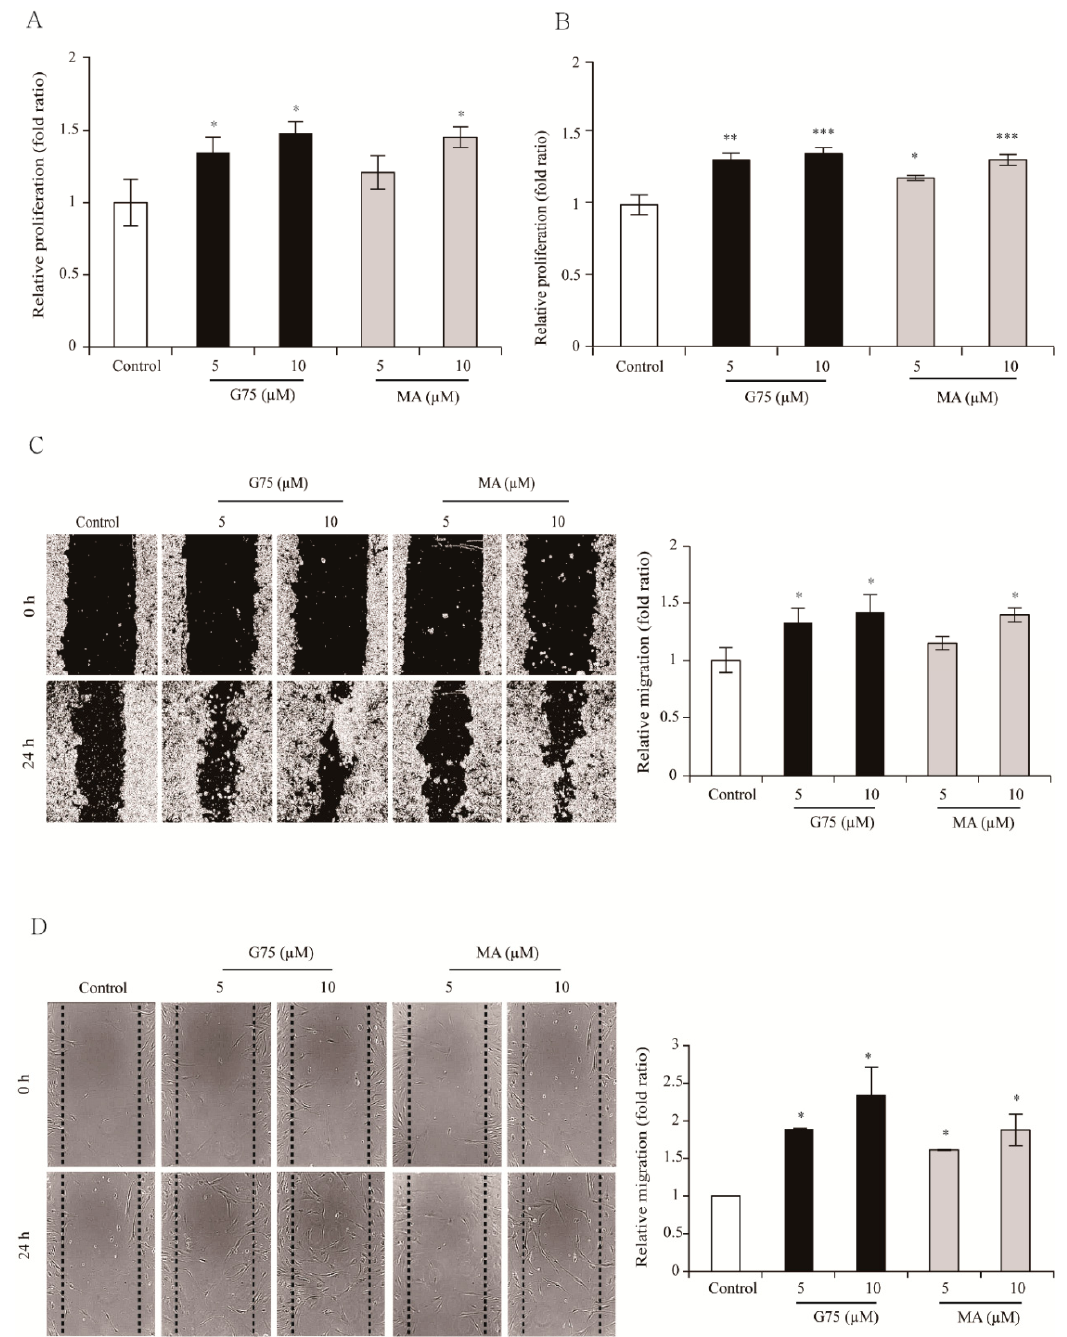
Figure 2. Wound healing effects of G75 in vitro. G75 induced cell proliferation in ( A ) HaCaT and ( B ) fibroblasts. After incubation for 48 h with indicated concentrations of G75 or MA, cell viability was assessed using MTT assay. G75 induced migration in ( C ) HaCaT and ( D ) fibroblasts. In vitro wound closure was assessed by a scratch wound closure assay. Wound closure after 24 h of incubation was calculated. The results are presented as means ± S.E.M ( n = 3 wells per condition). * p < 0.05, ** p < 0.01, *** p < 0.001, two-tailed Student’s t -test.